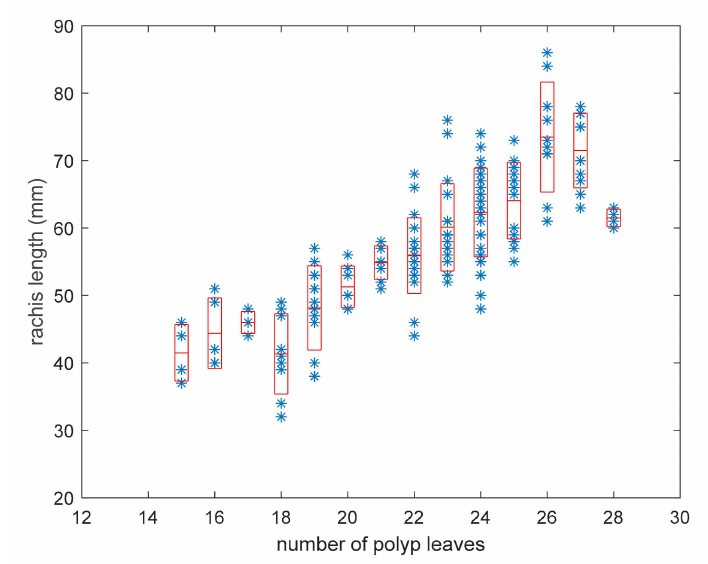
Figure 3. Distribution of rachis length in the population of Pennatula rubra ; red boxes include all values ranging in average ± standard